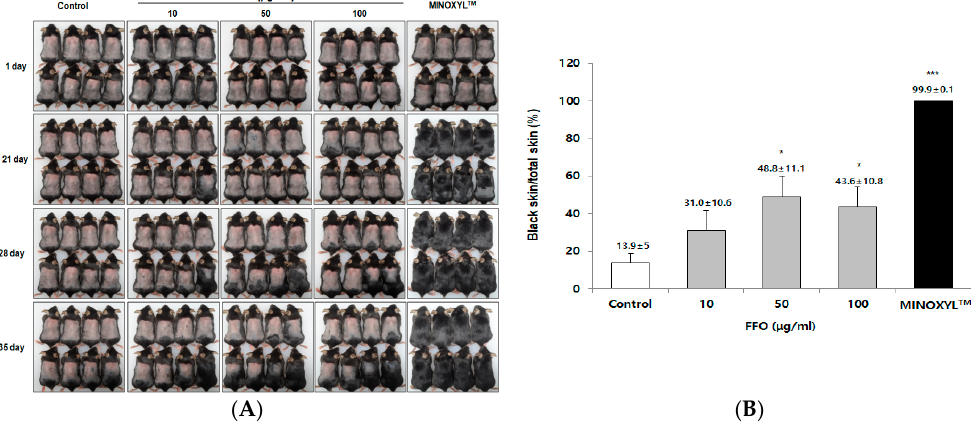
Figure 2. FFO extract accelerated hair cycle progression to anagen phase in C57BL/6 mice. FFO